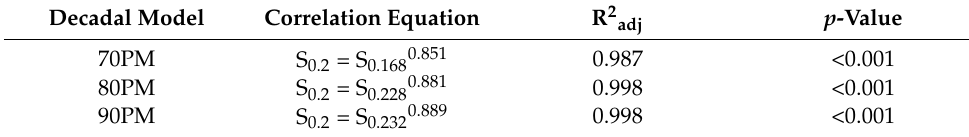
Table 3. The S correlation equation for each decadal group in Peninsular Malaysia.